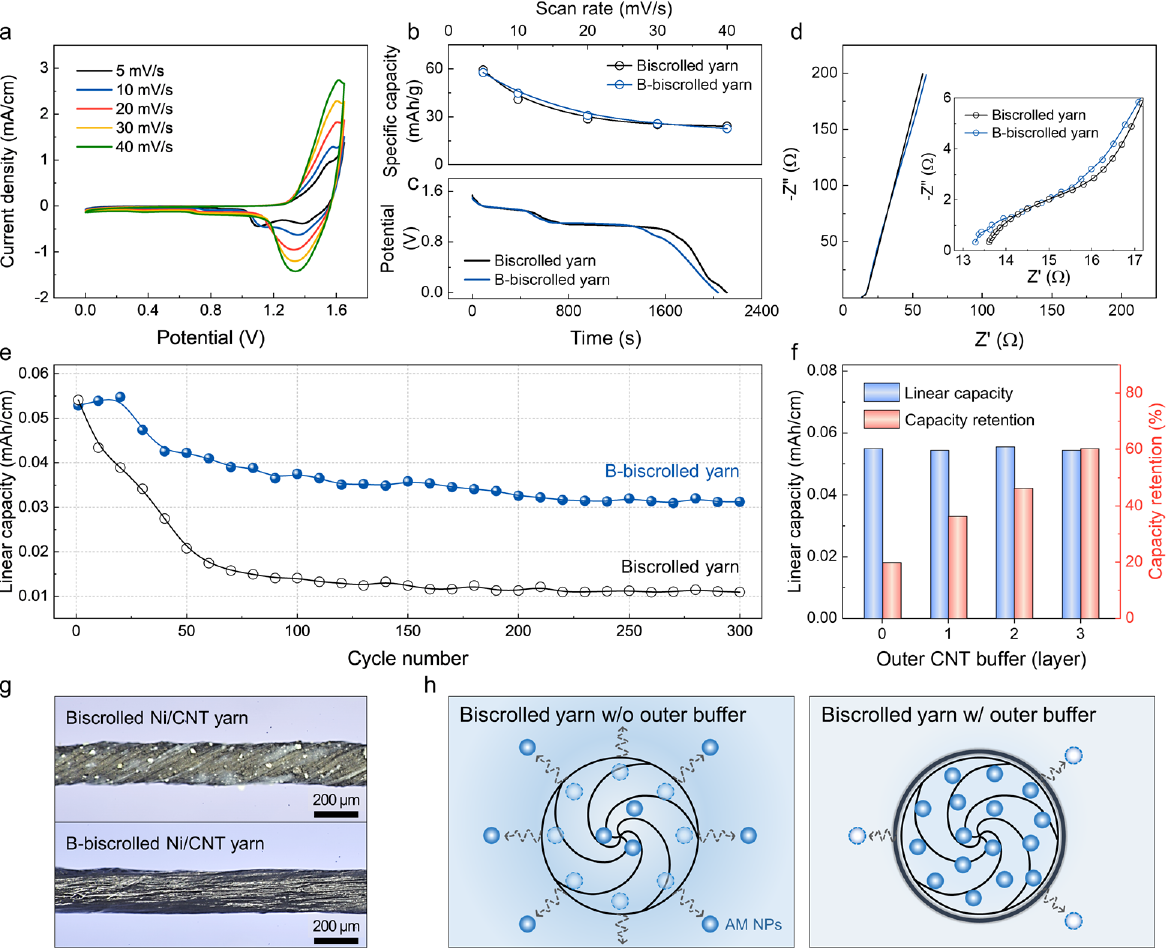
Figure 2. Electochemical characterizations of the BNF yarn batteries. ( a ) CV curves of b—BNF yarn battery in aqueous 6M KOH at different scan rates. ( b ) Average specific capacity as a function of the scan rate, ( c ) galvanostatic discharge curves at 0.1 mA/cm, ( d ) Nyquist plots (from 10 Hz to 100 kHz), and ( e ) cycling stability of BNF and b—BNF yarn batteries at 0.1 mA/cm. Inset in d shows enlarged section of Nyquist plots. ( f ) Dependence of linear capacity and capacity retention on outer CNT buffer layer. ( g ) Optical images show biscrolled Ni/CNT yarn ( top ) and b—biscrolled Ni/CNT yarn ( bottom ). ( h ) Schematics show the expected AM NP desorption process (indicated by arrows) of the biscrolled yarns without ( left ) and with ( right ) an outer CNT buffer layer in an aqueous elec- trolyte.